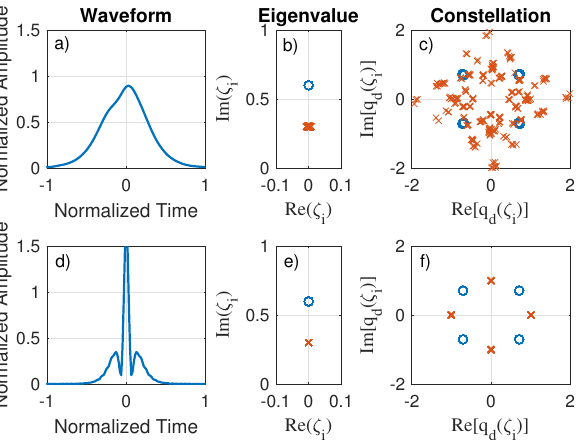
Figure 6. Simulation of the baseline system at 1600 km of propagation distance with launch power 11 dBm. ( a – c ) Results with T S = T S1 . ( d – f ) Results with T S = T S2 for the same launched symbol. ( a , d ) Received waveform of one symbol of the sequence. ( b , e ) Received eigenvalues. ( c , f ) Normalized received spectral function evaluated at the two eigenvalues: q d ( ζ 1 ) in blue circles and q d ( ζ 2 ) in red